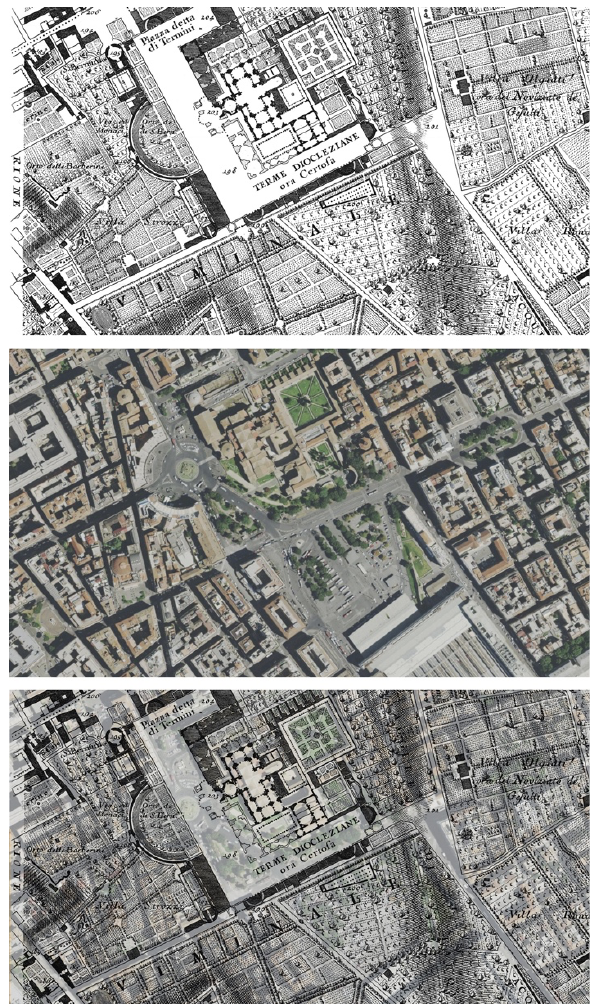
Figure 03 . From top to bottom: Nolli Plan (Nolli, 2016) of the area, aerial photography (2021), superimposition of the Nolli plan with aerial photography. In the last picture is clear the connection between Piazza della Repubblica and the old structure of the baths.